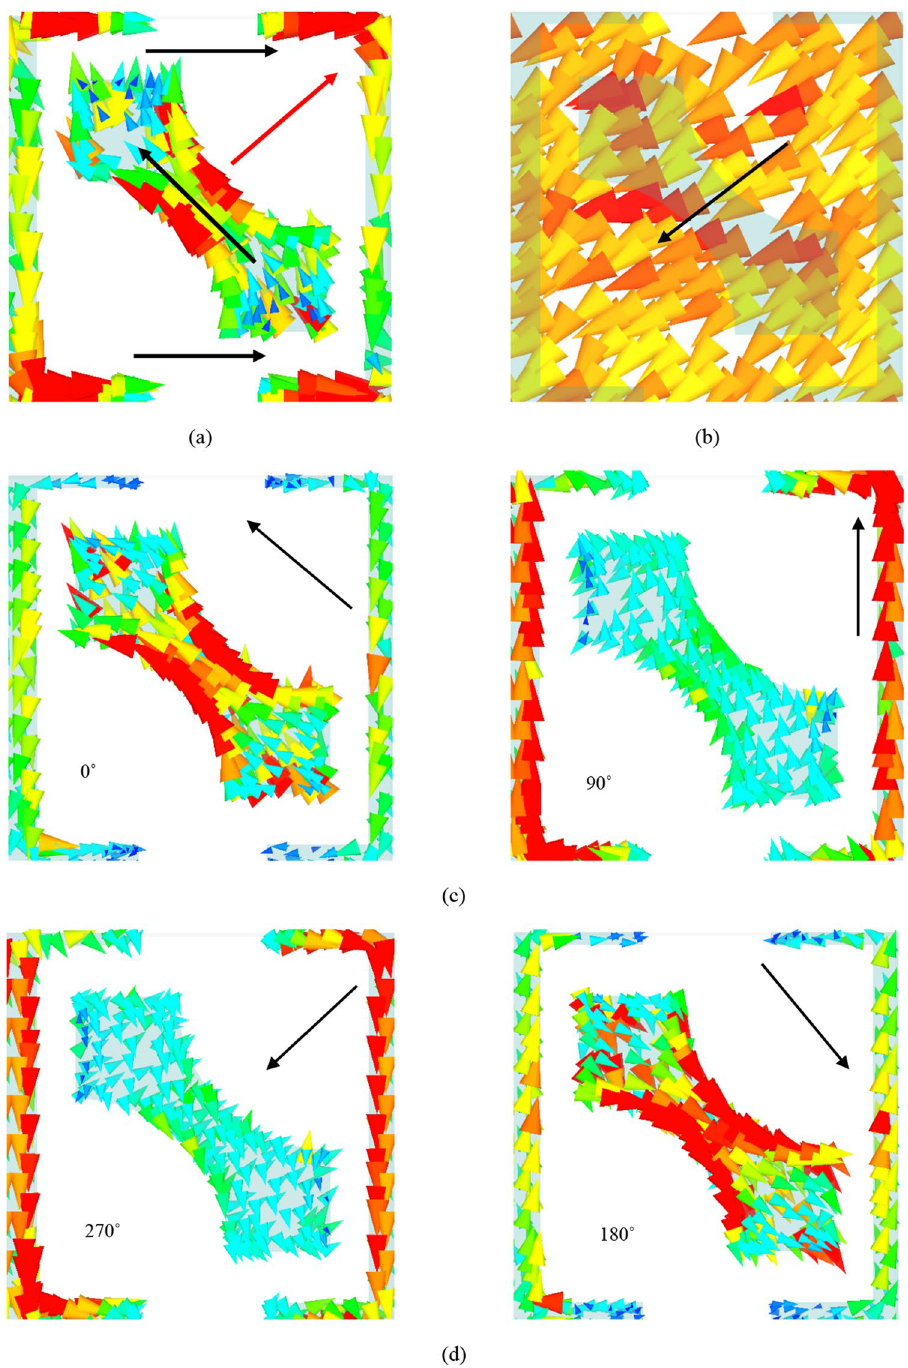
Figure 7. Surface current distribution on ( a ) top and ( b ) bottom of the proposed structure at the frequency of 16 GHz. (Red arrow is the resultant vector of the black arrows.). Surface current distribution at ( c , d ) 13 GHz, ( e , f ) 18 GHz. (All the figures are generated with CST Microwave Studio software version